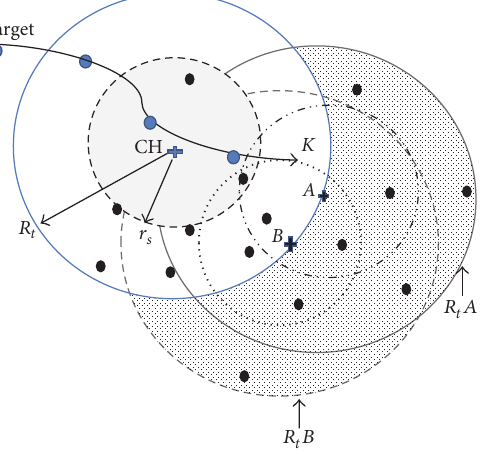
Figure 2: Activation of nodes in sleep